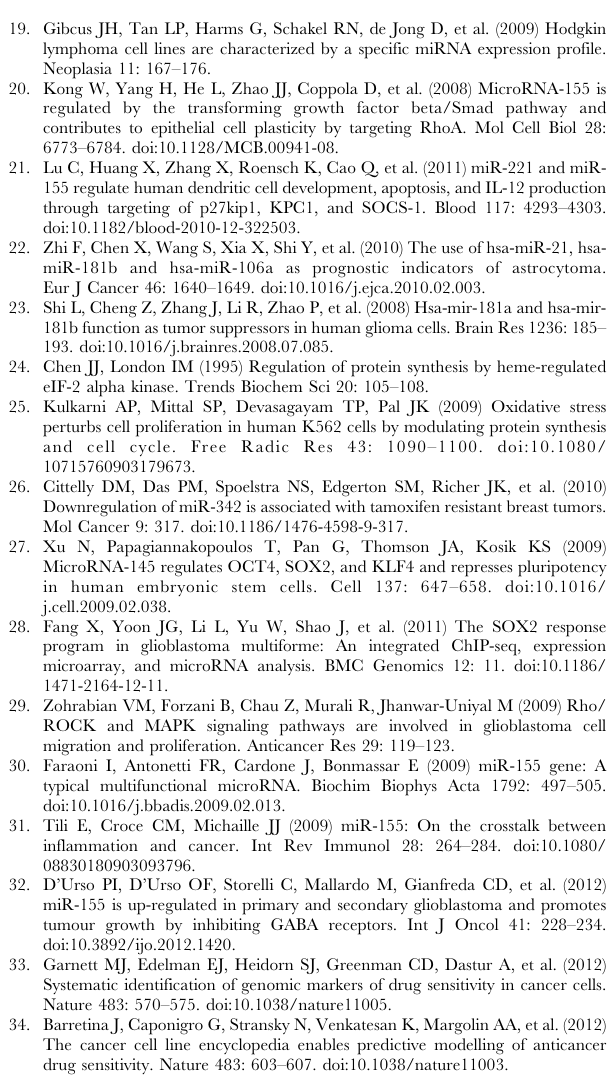
line, n= 22) with a twofold change threshold between the patient groups. The normal average expression group is denoted with a green line (0 group, n= 135). Table S1 An Excel file of screening data from miRNA pre-miR libraries in glioma cell lines. Sheet 1) Data from the human pre- miR miRNA Precursor library v2 (Ambion Inc., 319 molecules) screening. Data have been normalized for row and column effects. Sheet 2) Data from the human miRIDIAN microRNA Mimic Libraries v10.1 (Dharmacon, Lafayette, 819 molecules) screening. Data are presented as Loess log normalized log 2